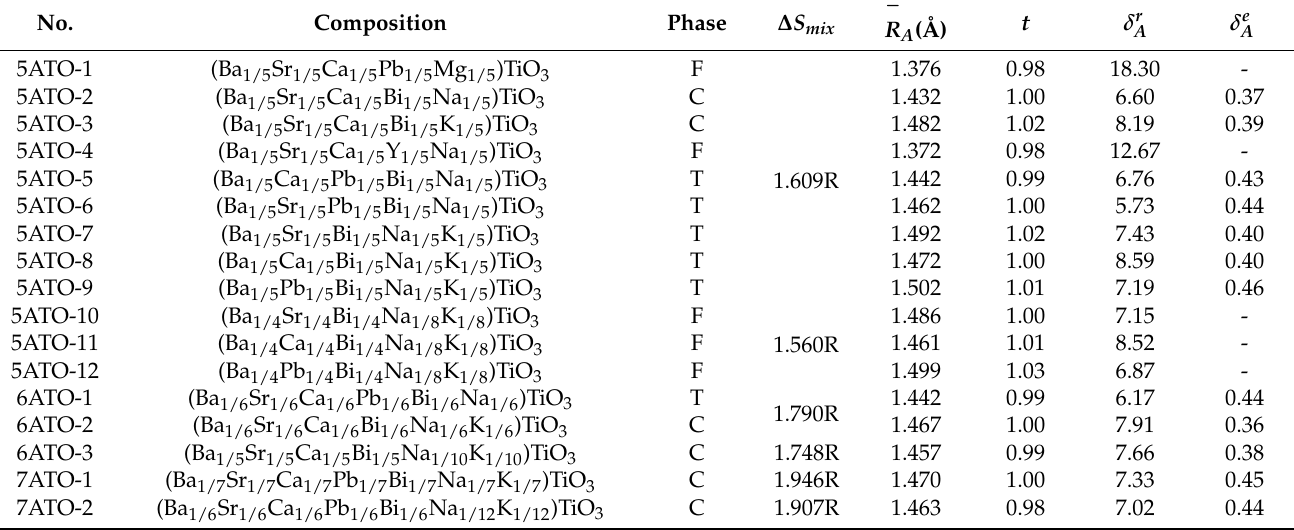
Table 1. Summary of important results of 17 kinds of